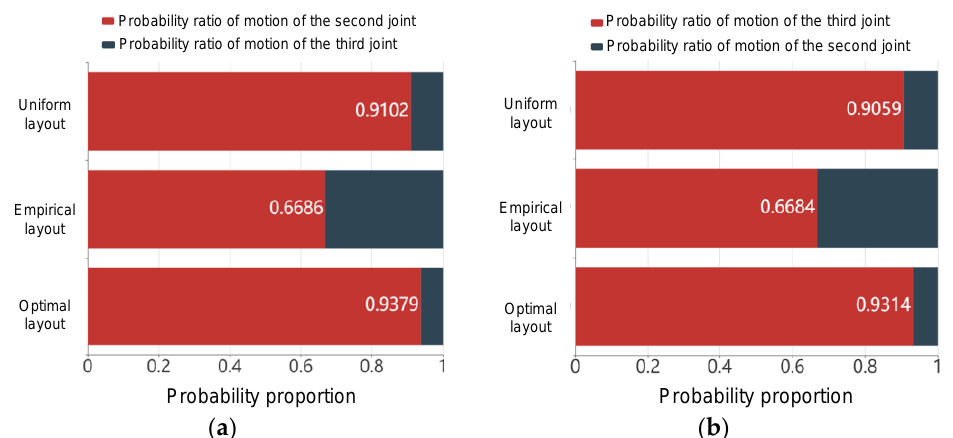
Figure 14. Probabilistic verification of three layouts: ( a ) Probability verification of the second joint movement, ( b ) Probability verification of the third joint in motion.